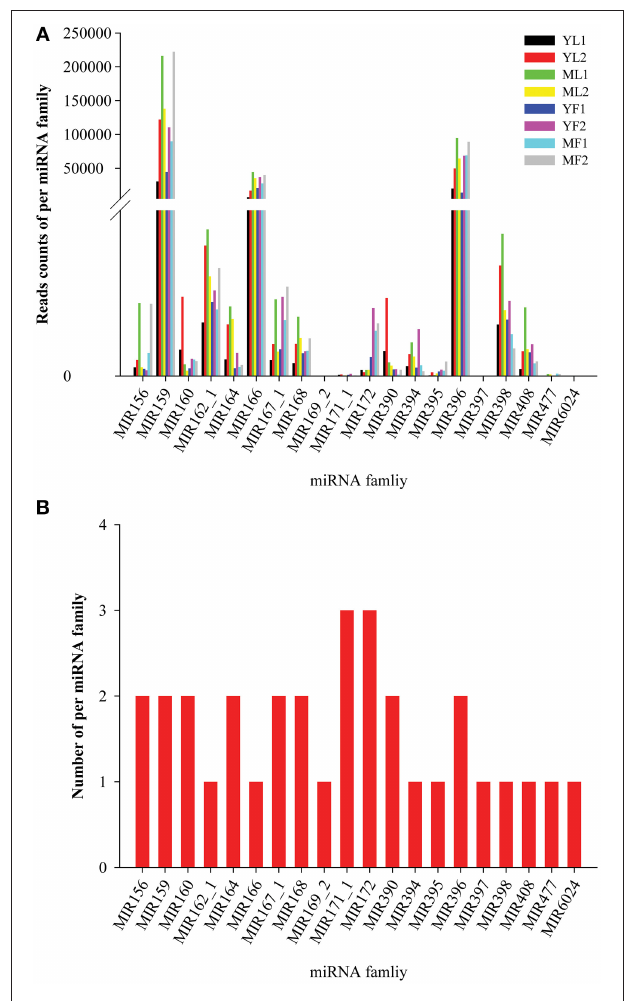
FIGURE 2 | Abundance (A) and distribution of the member numbers (B) in each conserved miRNA family in Eucommia ulmoides